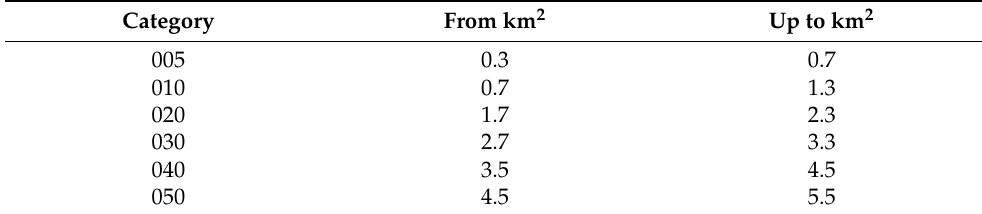
Table 1. SHC categories. Each category is characterized by area.